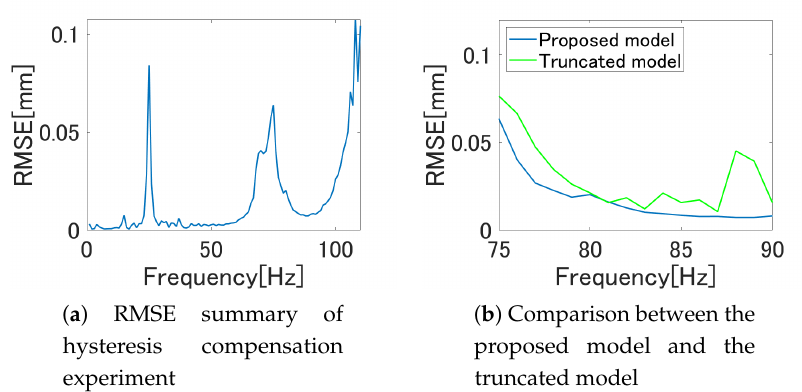
Figure 17. Results of the hysteresis compensation experiment.